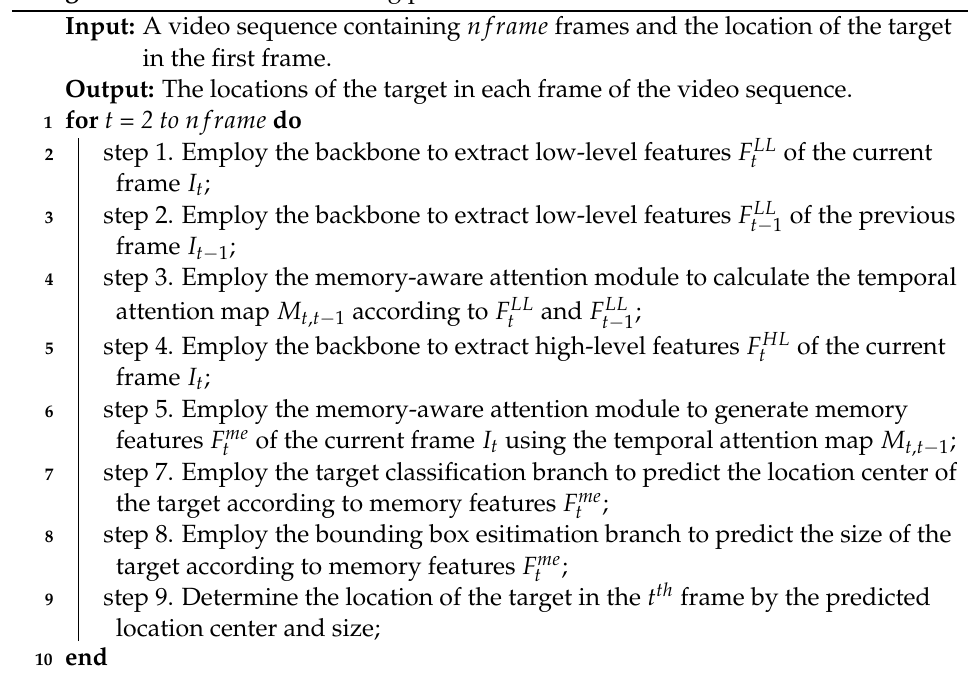
Algorithm 1: The online tracking process of our